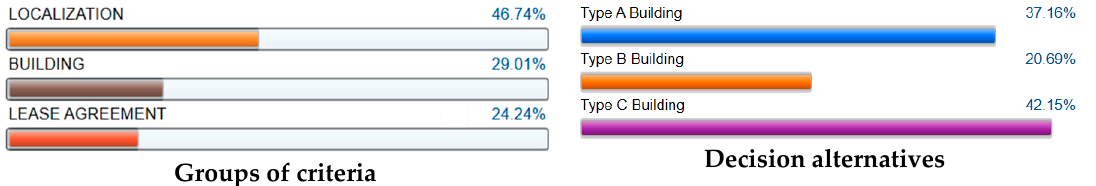
Figure 1. Aggregated results of experts’ evaluations with prioritisation of groups of criteria related to the decision alternatives (%).